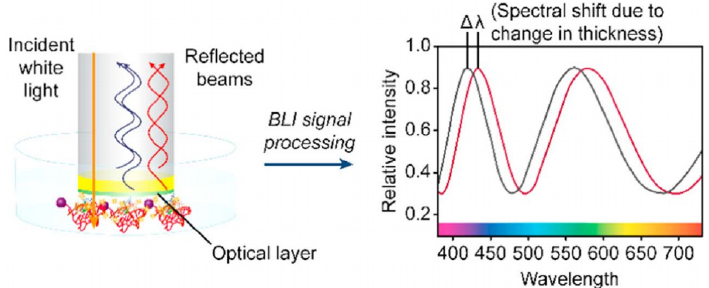
Figure 12. Schematic of BLI. Reproduced from ref. [90] with permission from Elsevier.